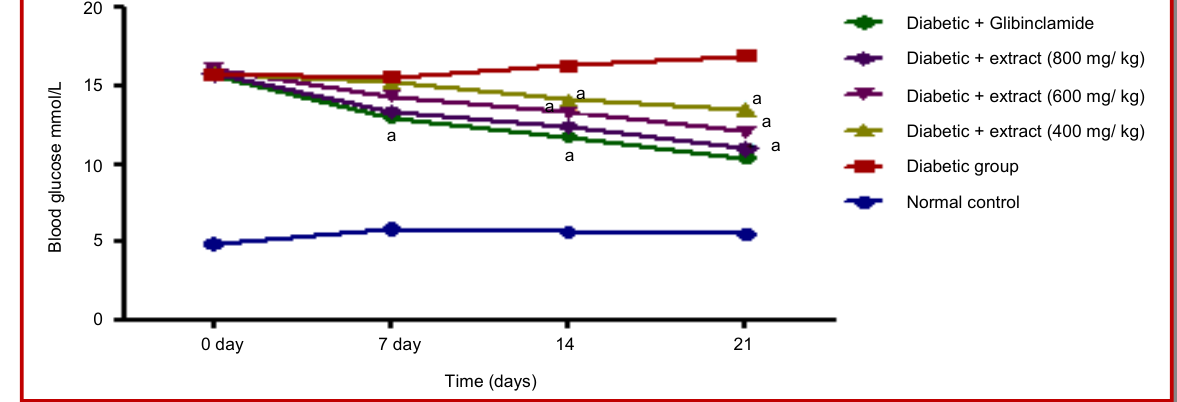
Figure 1: Effect of oral administration of ethanolic extract of Pericampylus glaucus and glibenclamide on plasma glucose level of streptozotocin-induced diabetic rats Data are expressed as mean ± SEM; n = 5; a p<0.001 significant as compared to diabetic control, statistical test employed was ANOVA followed bmy Bonferroni